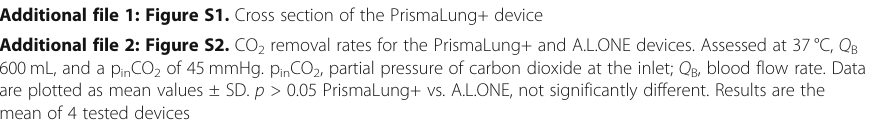
Additional file 1: Figure S1. Cross section of the PrismaLung+